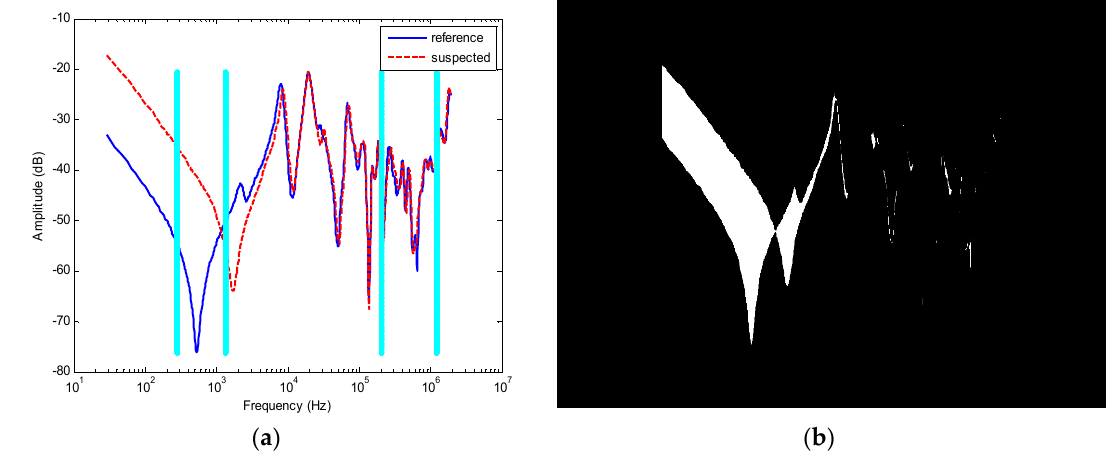
Table 3. Diagnosis result of Case 1. Methods